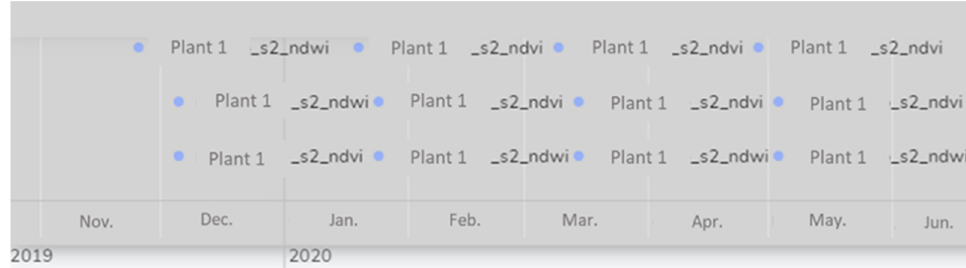
Figure 4. Calendar of the available satellite products.